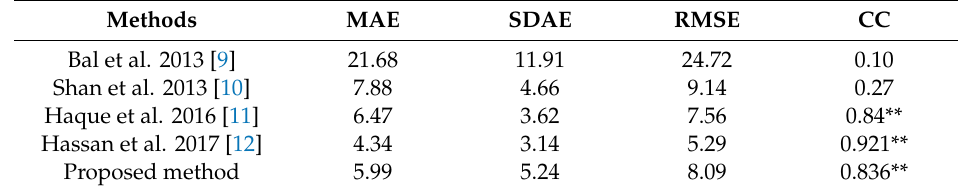
Table 5. Comparison of the proposed method and other remote BCG methods in experiment